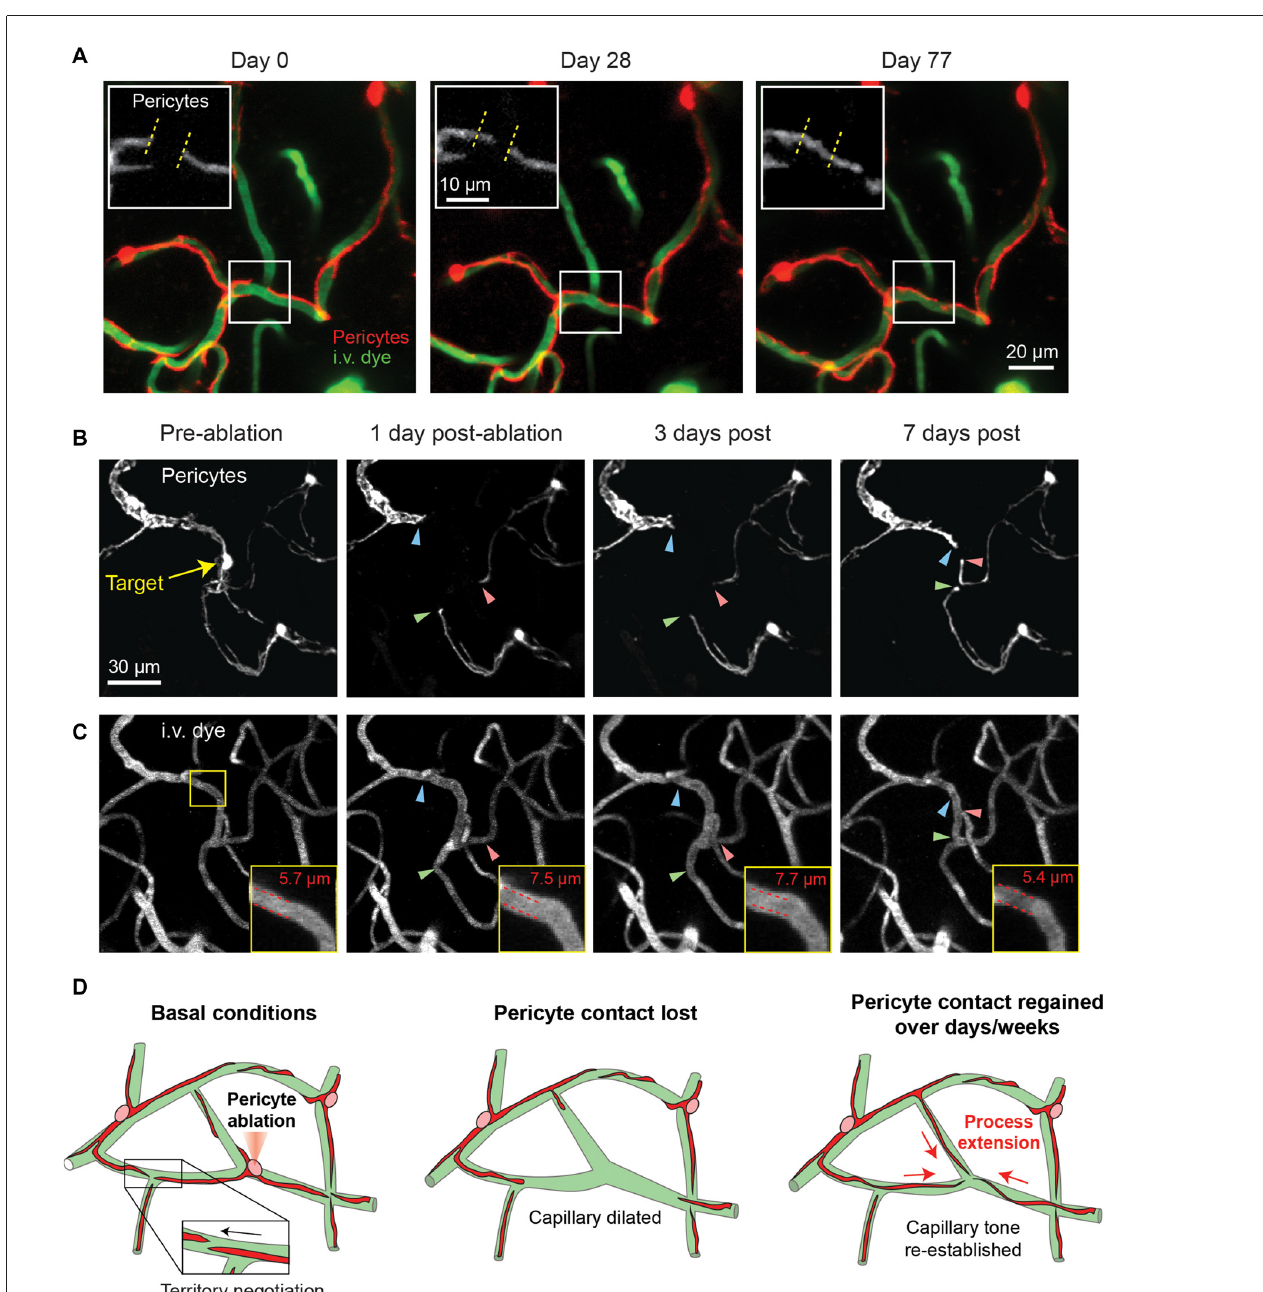
FIGURE 4 | Pericyte structural remodeling captured with chronic in vivo 2-photon imaging. (A) An example of the structural dynamics of adjacent pericytes under basal conditions. Inset shows the extension of a pericyte process beyond its territory at Day 0, and the corresponding retraction of a neighboring pericyte process. Images are from a Myh11-tdTomato mouse. Adapted from Berthiaume et al. (2018). (B) Two-photon laser ablation of a single pericyte results in the robust extension of immediately adjacent pericyte processes into the vacated territory over 7 days. The image shows the extension of two thin-strand pericytes (green and red arrowheads) and one mesh pericyte (blue arrowhead). Images are from a Myh11-tdTomato mouse. (C) Images of the vasculature, labeled by 2 MDa FITC-dextran, at the site of pericyte ablation (same region as panel B ). Inset shows an increased capillary diameter in the vessel segment lacking pericyte coverage, which returns to baseline diameter once pericyte contact is regained suggesting vascular tone. (D) Schematic of pericyte structural remodeling under basal conditions and following acute pericyte ablation.